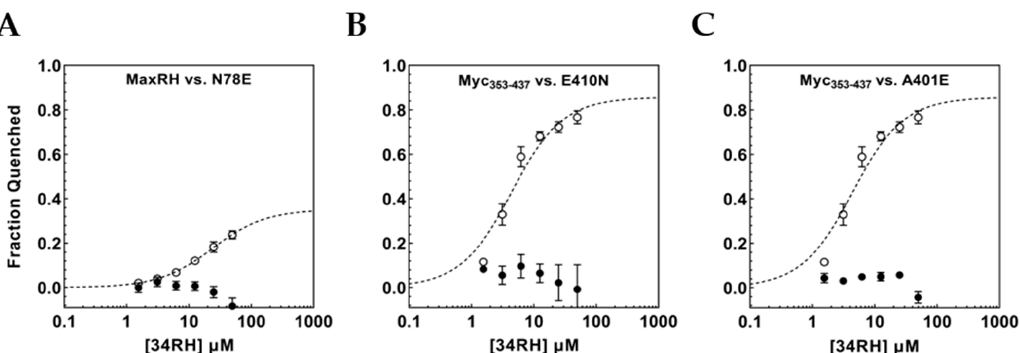
Figure 6. ( A ) MaxRH-N78E fluorescence quenching titration curve (black circles) overlaid with MaxRH curve (white circles). ( B ) Myc 353–437 E410N fluorescence quenching titration curve (black circles) overlaid with Myc 353–437 curve (white circles). ( C ) Myc 353–437 A401E fluorescence quenching titration curve (black circles) overlaid with Myc 353–437 curve (white circles). Error bars represent the standard error of three independent trials.